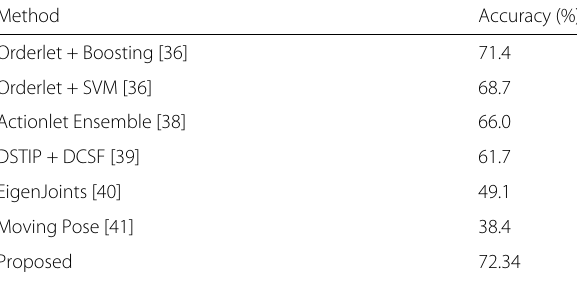
Table 5 Performance of different methods on activity classification (7 classes) using Dataset-B : classification accuracy